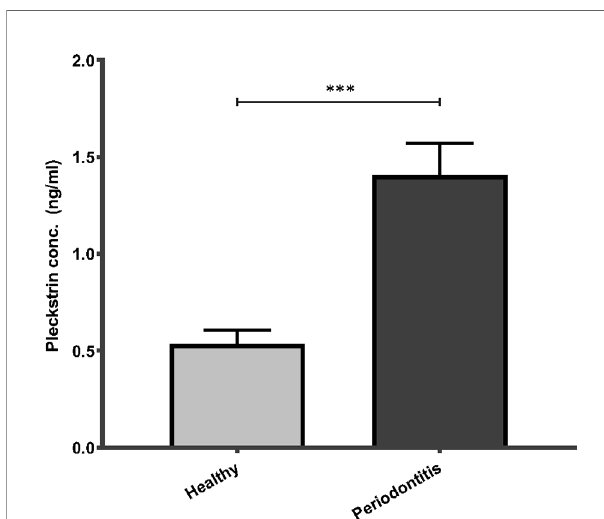
FIGURE 1 | Pleckstrin levels in saliva samples of patients with CP and controls. Bar plot showing salivary pleckstrin concentrations (ng/ml) of patients with CP compared with healthy controls. Data are presented as the mean values ± SEM. Signi fi cance was calculated following Mann Whitney test. ***p-value < 0.001. CP, Chronic periodontitis.